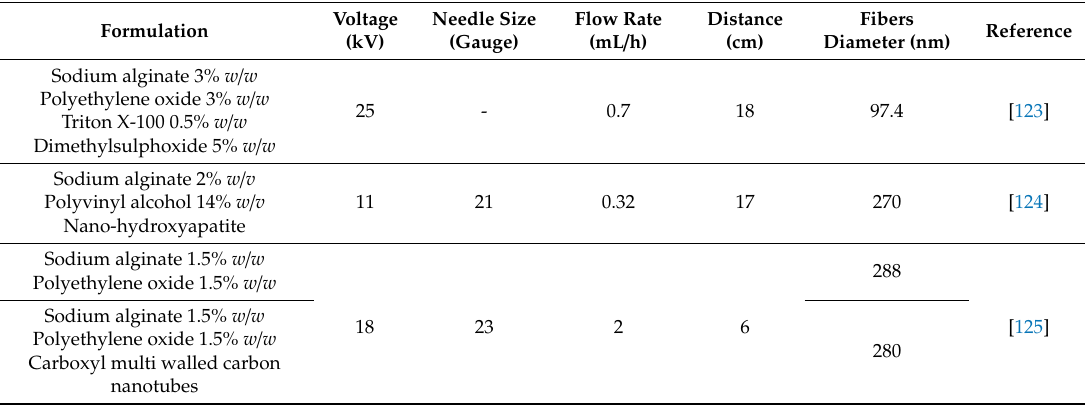
Figure 8. Schematic representation of electrospinning technique. Table 2. Preparation of alginate nanofiber by electrospinning technique.